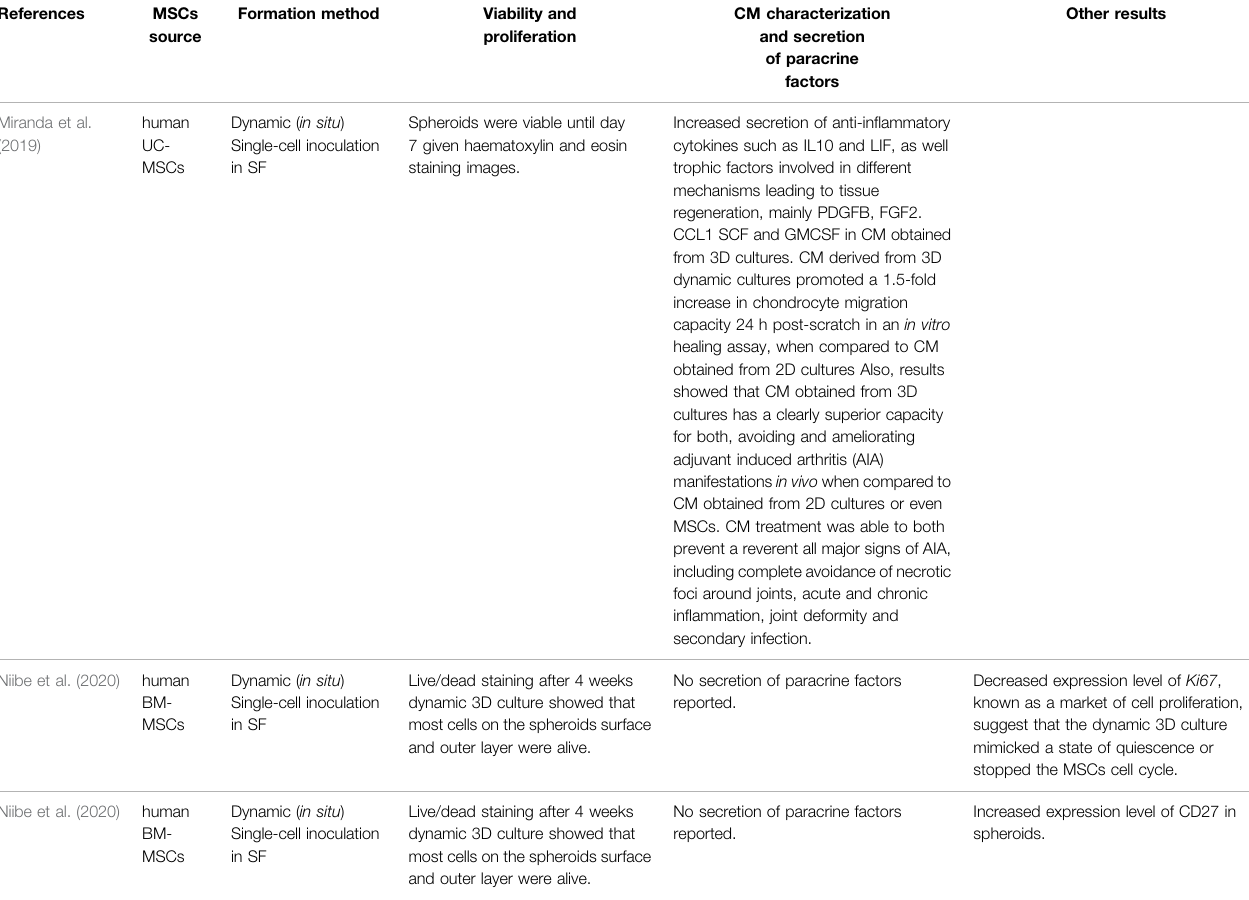
TABLE 2 | ( Continued ) Comparison of different studies reporting static and dynamic methods of spheroid formation and their impact on the CM pro fi